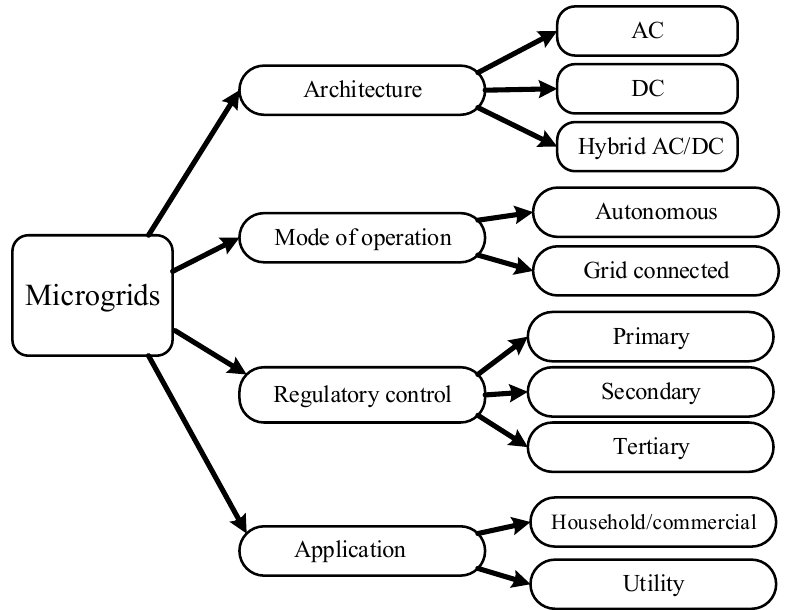
Figure 2. Classification of microgrids (own elaboration based on data from [13 ]).